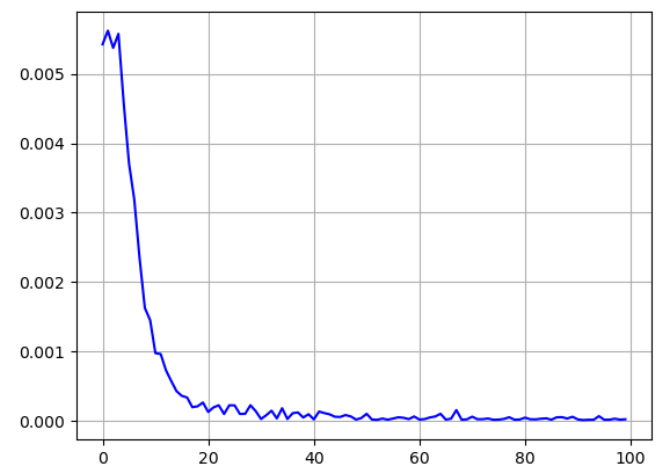
Figure A3. OIL Losses , 45 s.